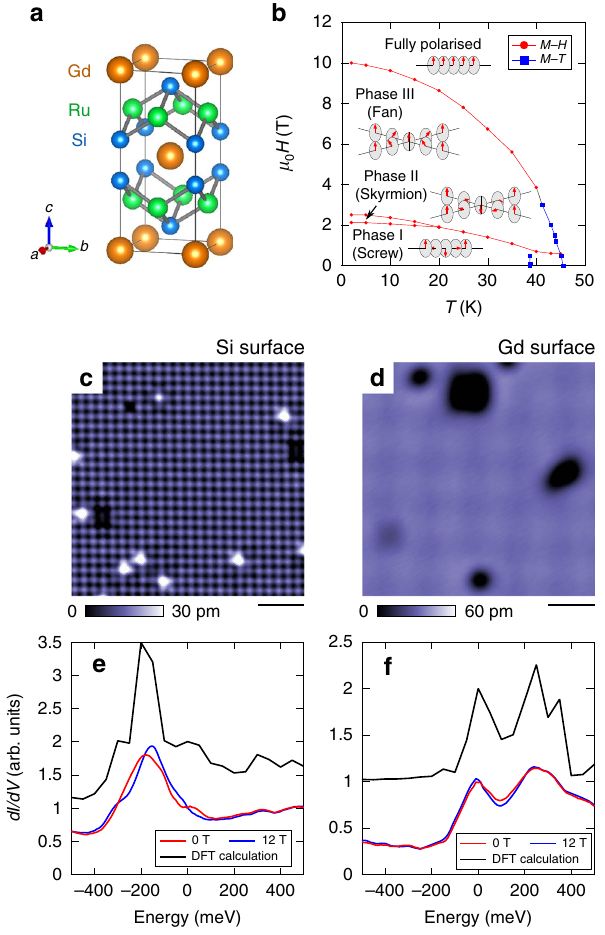
Fig. 1 Basic properties of GdRu 2 Si 2 . a Crystal structure of GdRu 2 Si 2 . b Magnetic phase diagram for magnetic fi eld H applied parallel to the c -axis. Data points shown with red circles and blue squares were obtained using H and T dependence of the magnetisation, respectively 9 . Schematics of the magnetic structures are depicted in insets. c , d Constant-current topographic images of Si-terminated and Gd-terminated surfaces, respectively, at T = 1.5 K and μ 0 H = 0 T. The setup sample bias voltage was V = 100 mV, and tunnelling current was I = 100 pA. Scale bar 2 nm. s s e , f Spatially averaged conductance spectra for Si-terminated and Gd- terminated surfaces, respectively. The setup condition is V s = 500 mV and I = 100 pA. The bias modulation amplitude was V ¼ 10 mV. Calculated s mod LDOS spectra for collinear ferromagnetic order at a tip position 5 Å above the surface are also shown and vertically shifted for